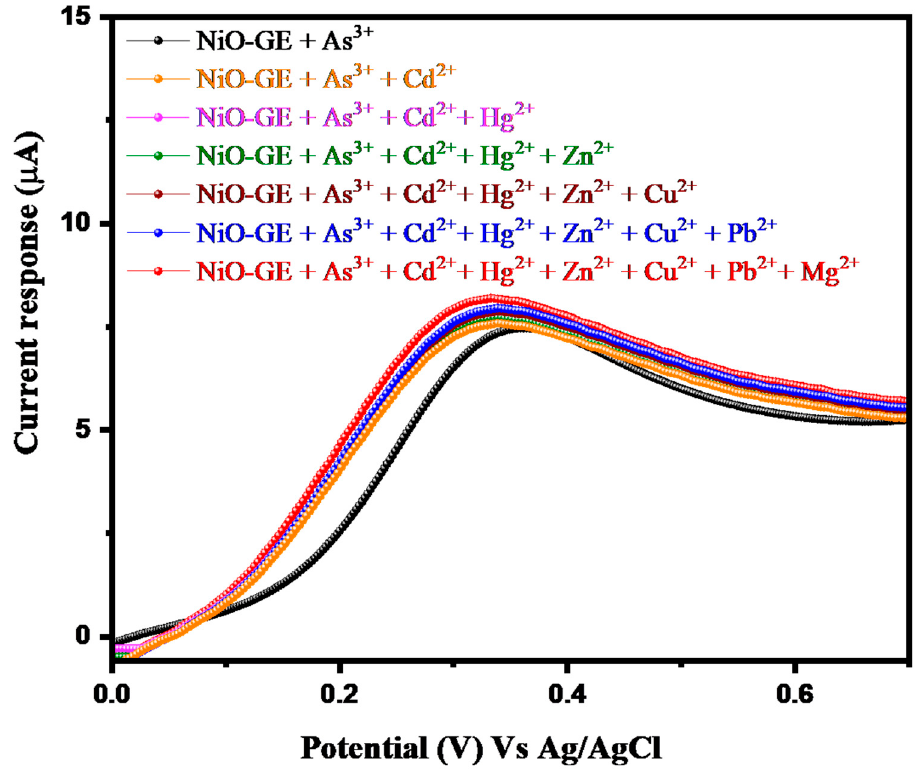
Figure 12. LSV response of NiO-GE for 5 ppb As 3+ and 5 ppb As 3+ + 30 ppb interferences (Cd 2+ , Hg 2+ , Cu 2+ , Zn 2+ , Mg 2+ , and Pb 2+ ) (0.1 M PBS of pH = 6) at scan rate = 50 mVs − 1 .